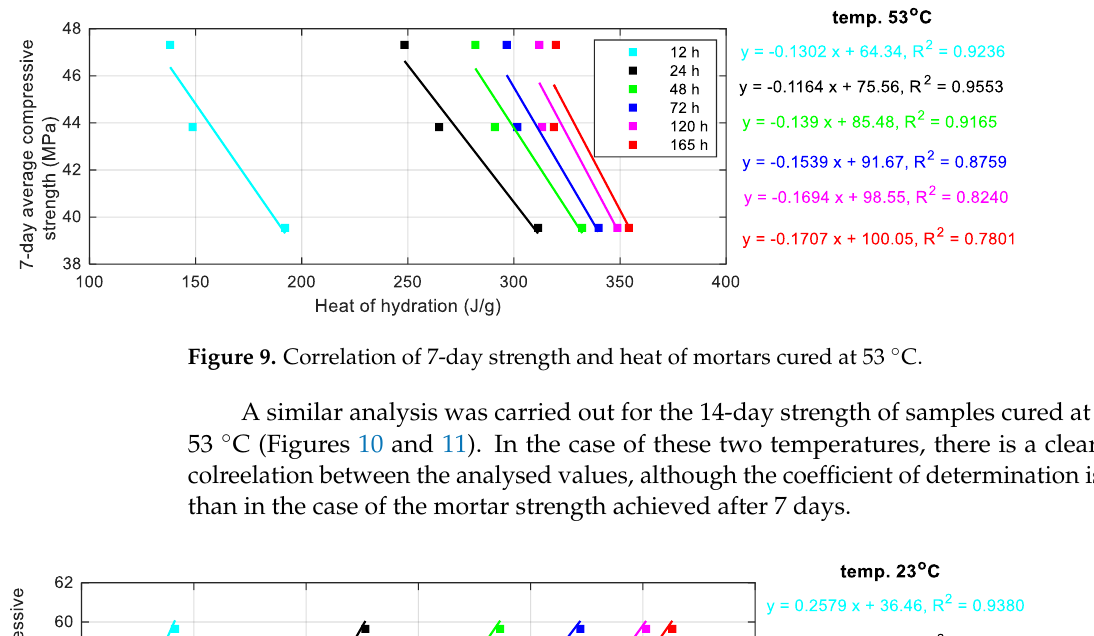
Figure 8. Correlation of 7-day strength and heat of mortars cured at 43 °C.